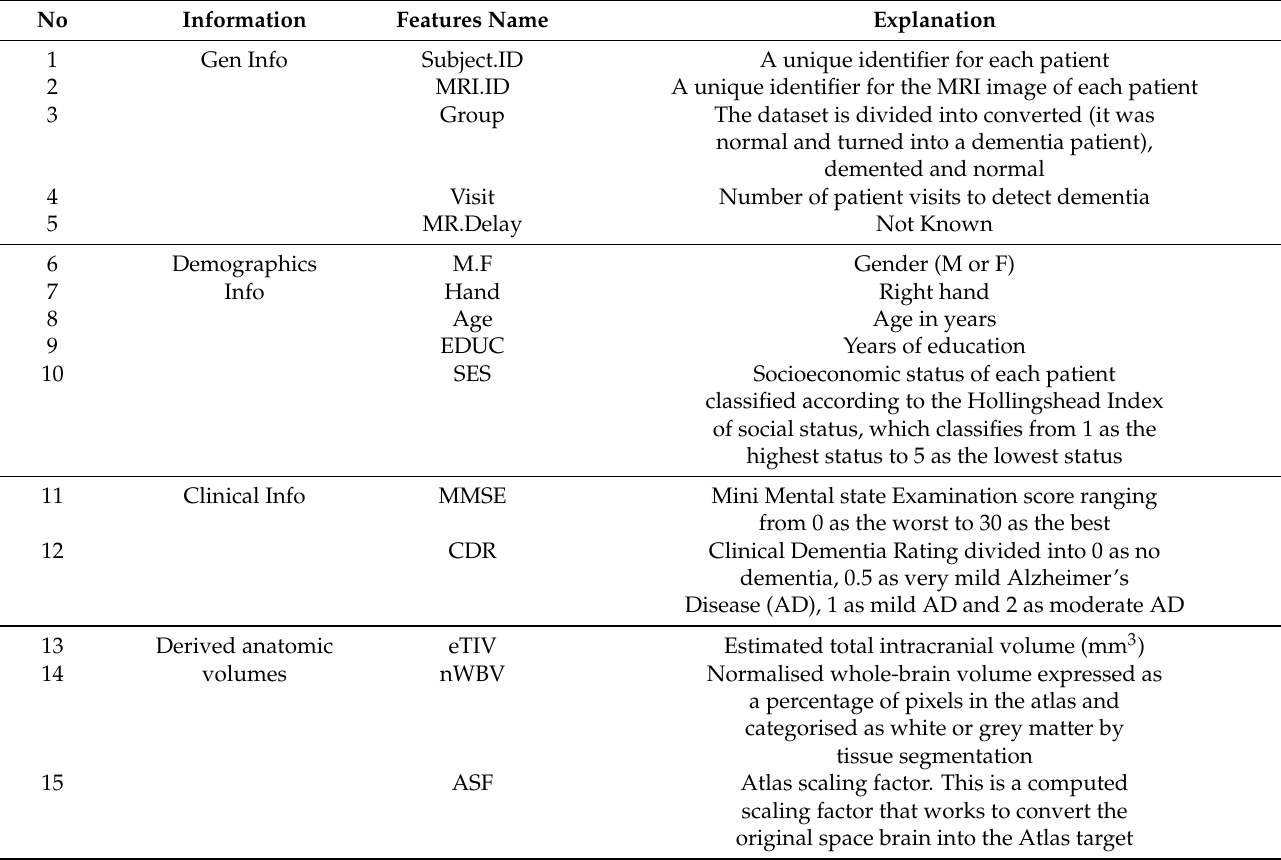
Table 1. Description of the OASIS dataset for the diagnosis of